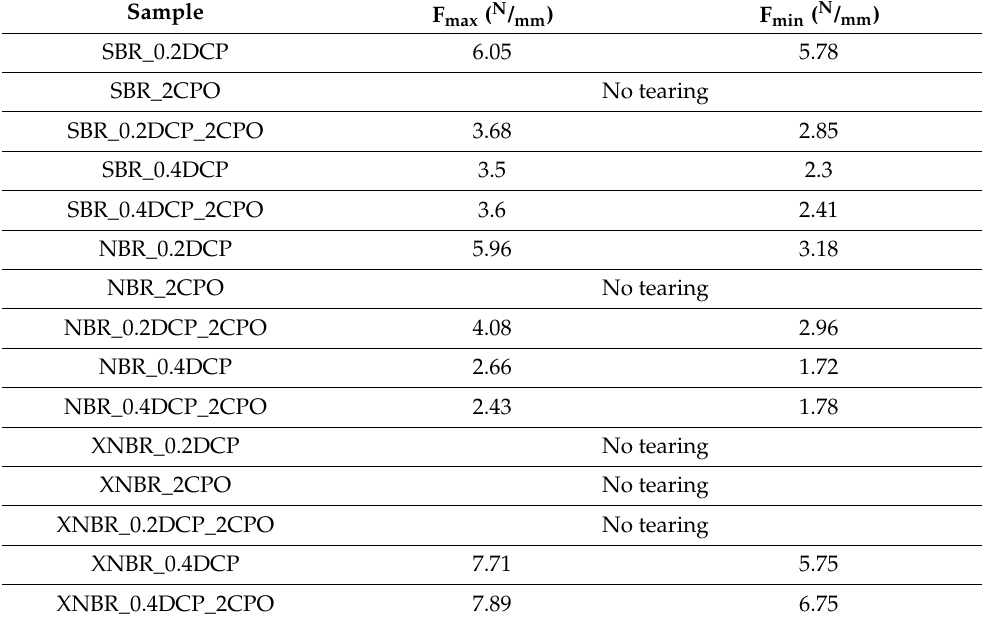
Table 5. Tear strength of the rubber samples